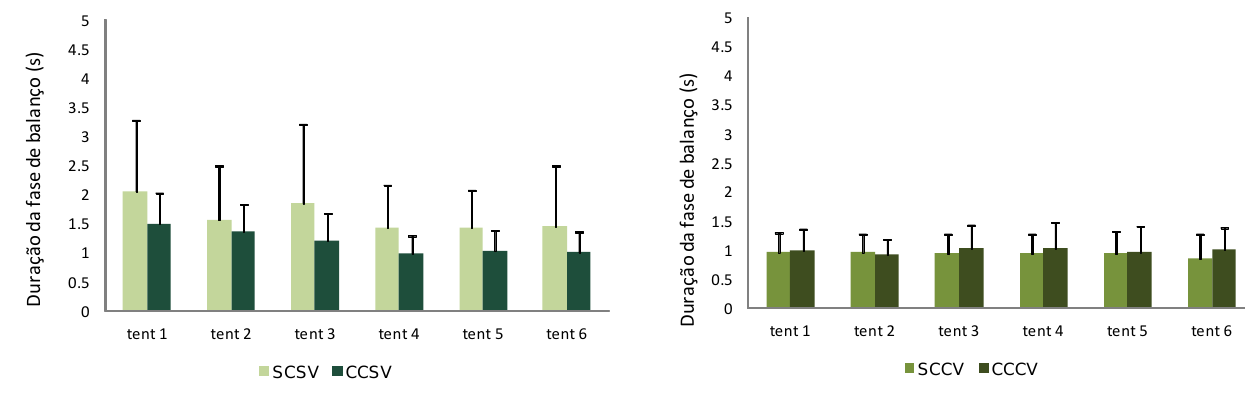
Figura 2. Média e desvio-padrão da duração da fase de balanço nas condições experimentais com e sem o cão, mas com uso da visão (lado direito) e com e sem o cão, mas sem o uso da visão (lado